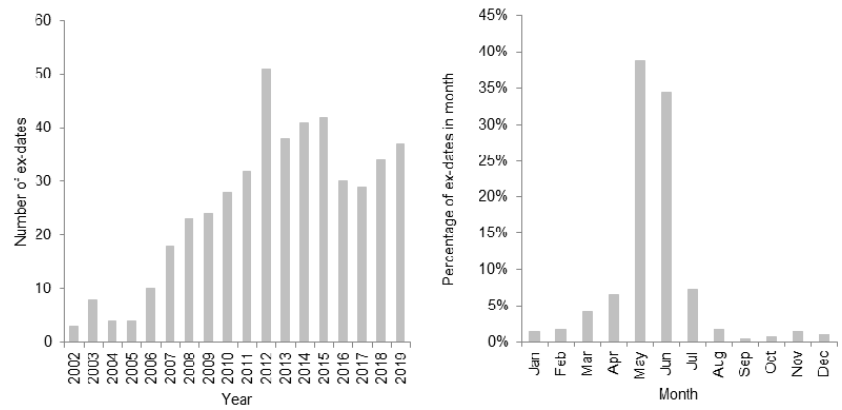
Figure 1. Distribution of ex-dates with tax-free dividends. This figure illustrates the distribution of